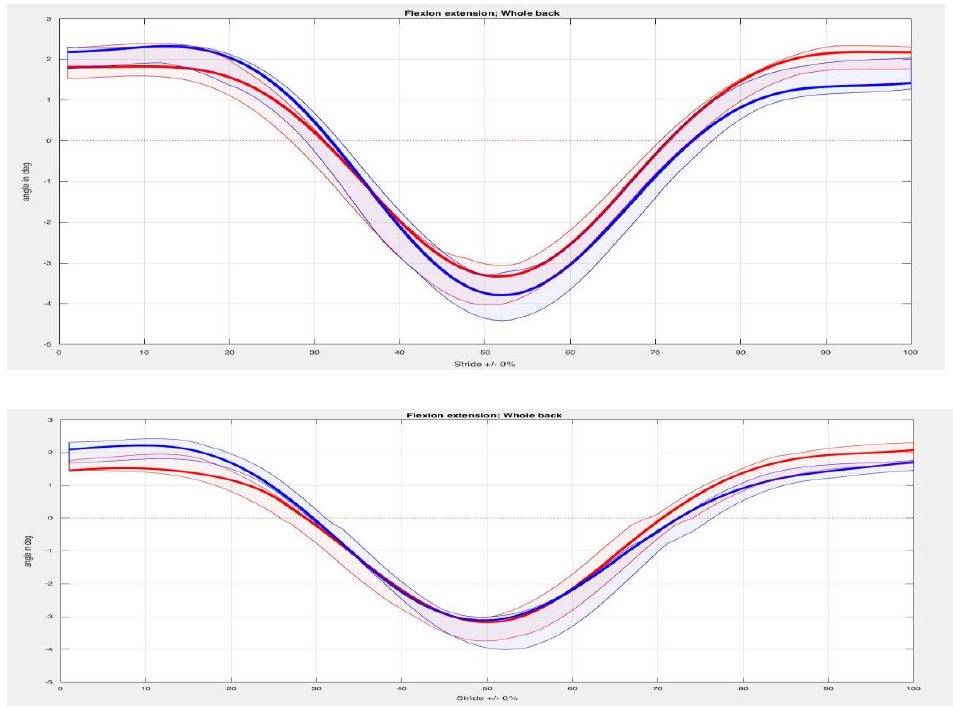
Figure A5. Flexion-extension angular patterns of T12 of horse no. 4 (mean stride) at trot without kinesiotape (the upper graph) and with kinesiotape (the lower graph). The thickened line indicates the mean, shaded area the standard deviation. Left hindlimb red and right hindlimb blue.